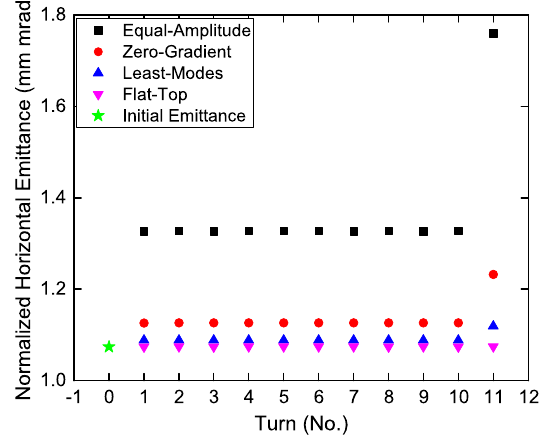
FIG. 8. Turn-by-turn normalized horizontal emittance for a single electron bunch in the two kicker scheme with 180 degrees betatron phase advance in between. The monitor is placed immediately after the injection kicker for the first 10 turns and after the extraction kicker for the last turn.